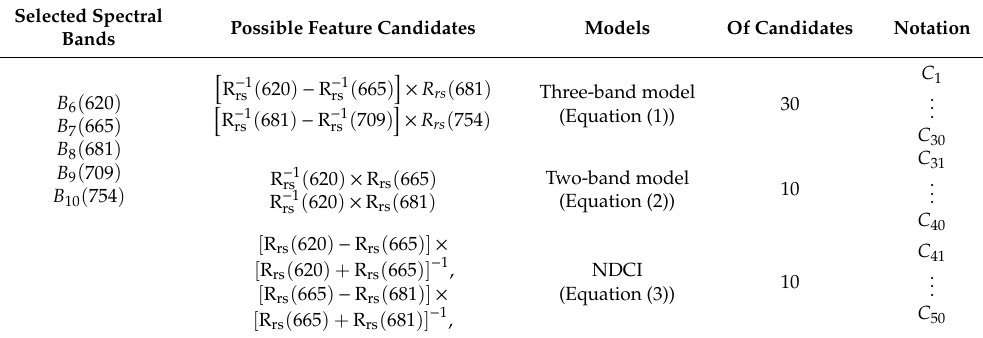
Table 1. Example of feature candidate generation from the selected